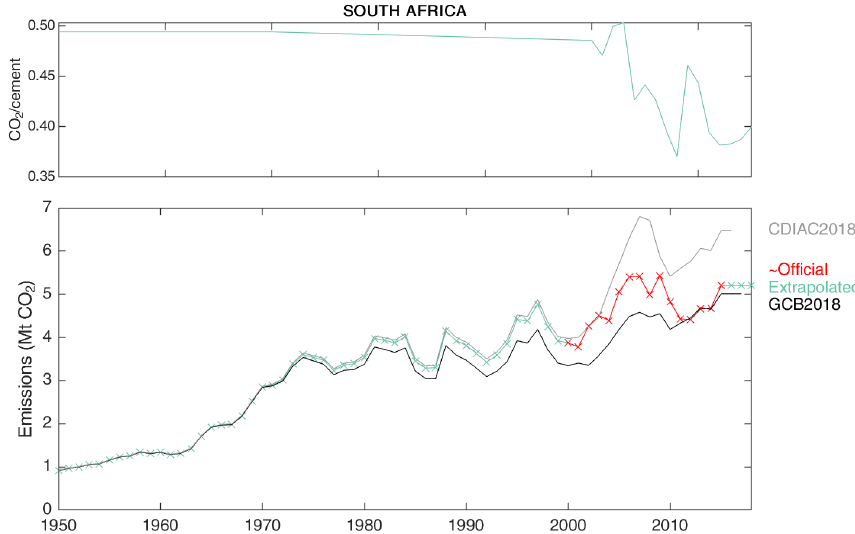
Figure C40. Revised cement emissions for South Africa.